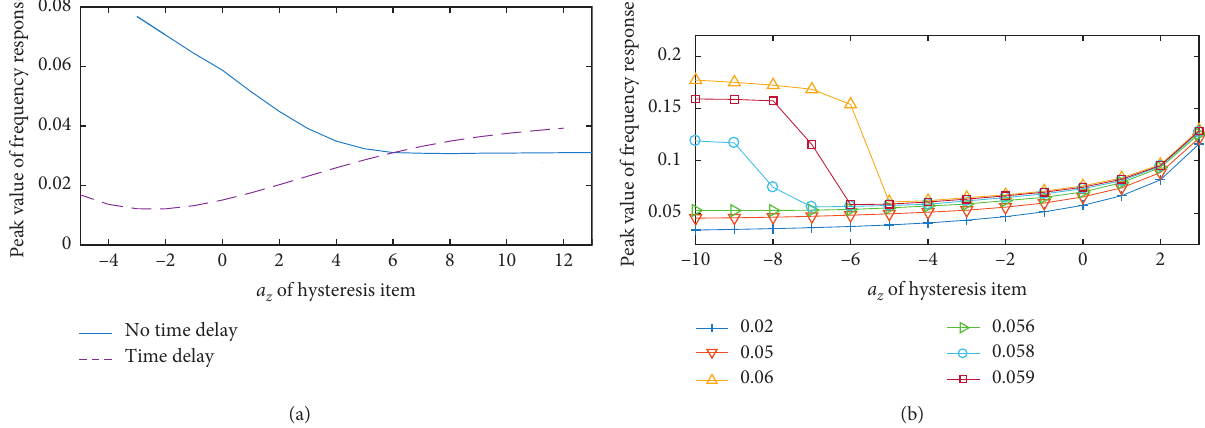
Figure 9: Peak of the amplitude-frequency characteristic curve. (a) Curves with and without time delay. (b) Curves with different time delays.